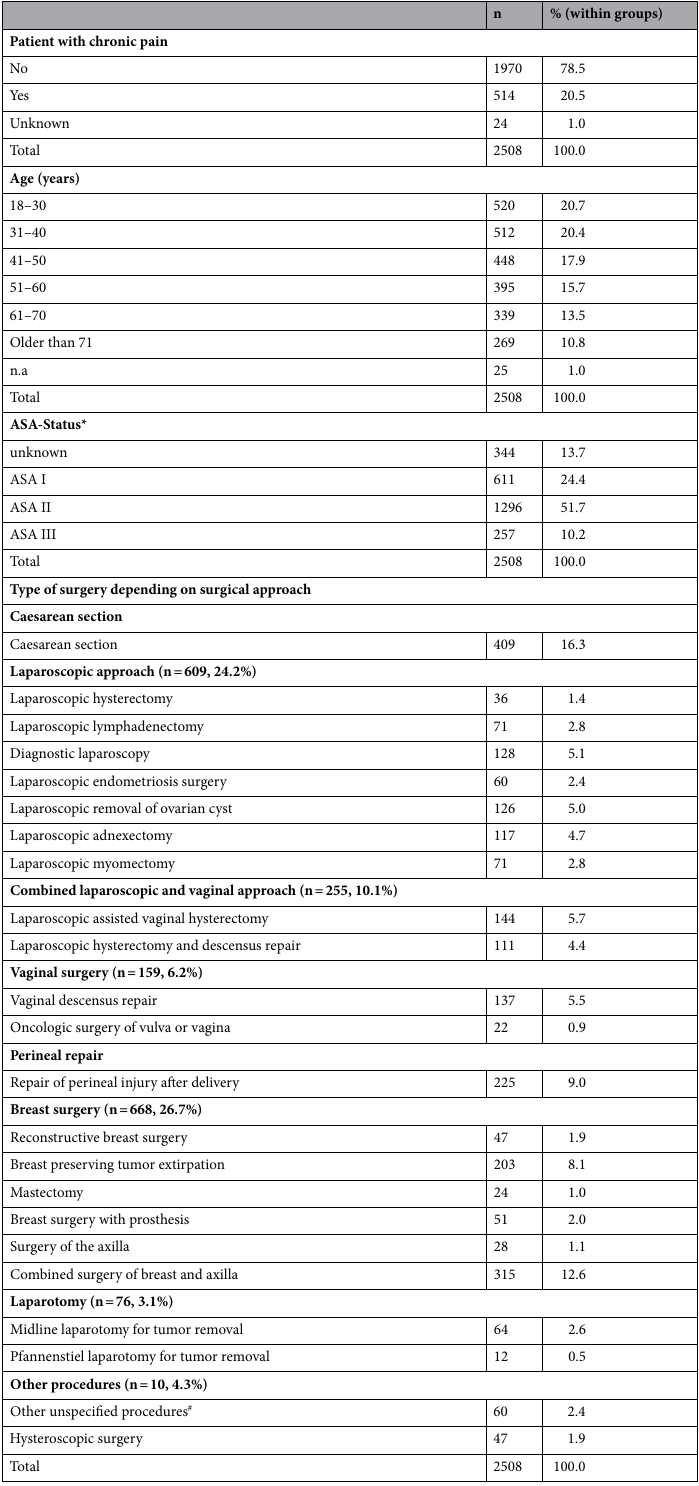
Table 2. Patient characteristics and surgical procedures. * ASA-Status American society Anaesthesiology, ASA 1 no organic pathology, ASA 2 moderate but definite systemic disturbance, ASA 3 Severe systemic disturbance from any cause, ASA 4 Extreme systemic disorders which have already become an eminent threat to life regardless, ASA 5 Moribund patient with little chance of surviving, ASA 6 Brain-dead organ donor. # In this group were included minor surgeries performed in at least 10 patients but not classifiable in other groups, for example because two different procedures were performed at the same time. These were 25 procedures combining hysteroscopy and laparoscopy, 13 patients with combined vulva and hysteroscopic surgery, 10 procedures for wound revision and 12 procedures involving removal of cutaneous or subcutaneous